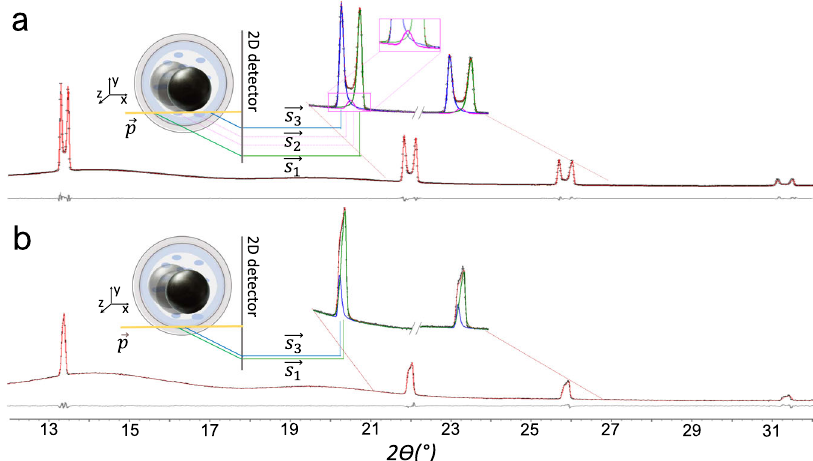
Fig. 2 Rietveld plot of the Si640d NIST standard at different diffraction geometries. In each case, the calculated pro fi le is given (red line) against experimental data (black dots) and the difference pattern is shown (grey line). The peak split is compatible with the geometrical constraints typically observed in an in situ mechanochemical experiment. The primary beam ~ p (yellow line) passes through the jar and is diffracted by the sample contained within. The contribution to the overall peak shape of the sample distributed within the jar is highlighted in the insets with different colours: the scattering vectors are produced by the sample located at the jar wall closer to the source ( ~ s 1 , green line), the wall nearer the detector ( ~ s 3 , blue line), and by the sample distributed randomly within the jar ( ~ s 2 , pink line). The difference in 2 θ angle between scattering vectors ~ s 1 and ~ s 3 is larger when the jar is in a general position with respect to the primary beam ~ p ( a ). The difference in 2 θ angle is minimised when the jar is accurately aligned ( b ), with negligible scattering contribution from the sample distributed within the jar (i.e. ~ s 2